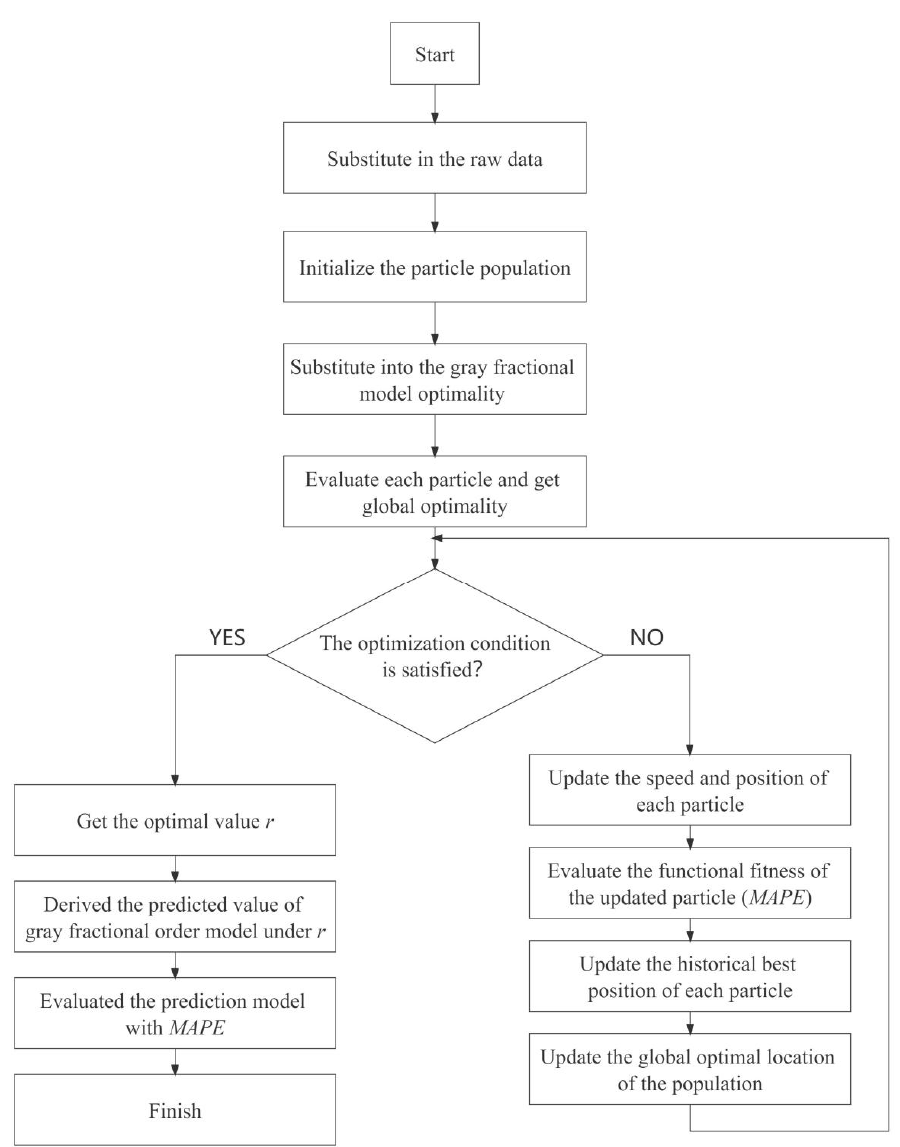
Figure 1. Algorithm flow chart.